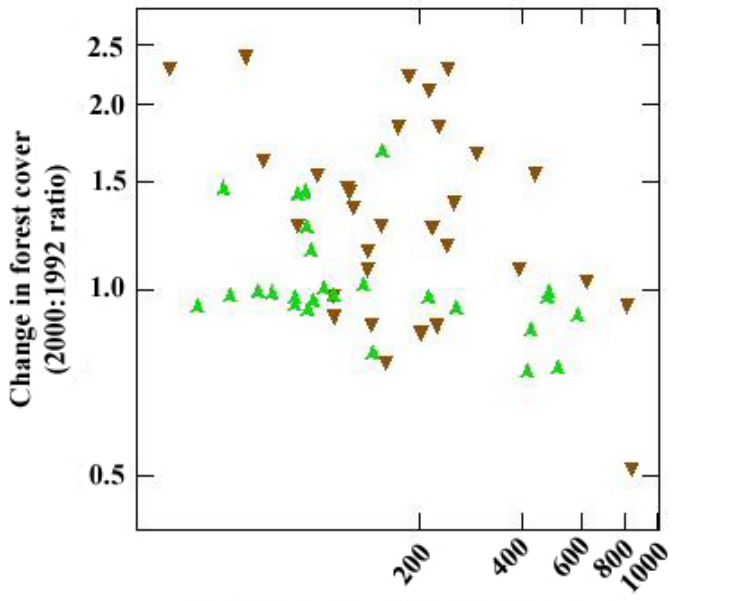
Fig. 9. The relationship between the change in total forest cover and gross agricultural income per hectare in 2000 for 57 districts in Panama. The change in total forest cover is expressed as the ratio of forest area in 2000 to that in 1992. Brown downward-pointing triangles indicate districts that were largely deforested before 1947; green upward-pointing triangles indicate districts that were largely forested in